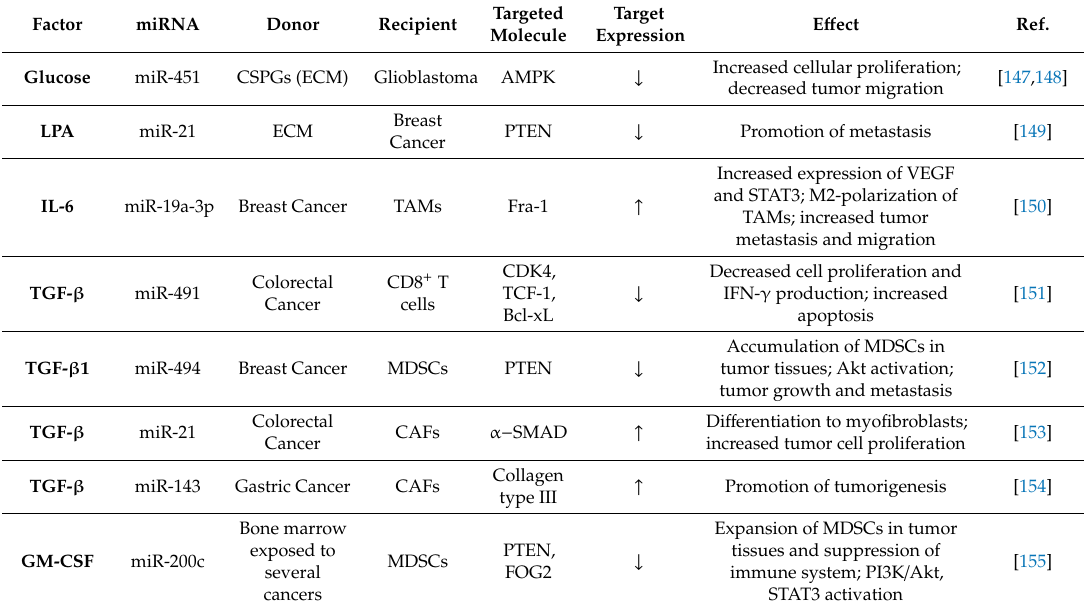
Table 1. Examples of induced miRNAs by cell–cell communication within the tumor